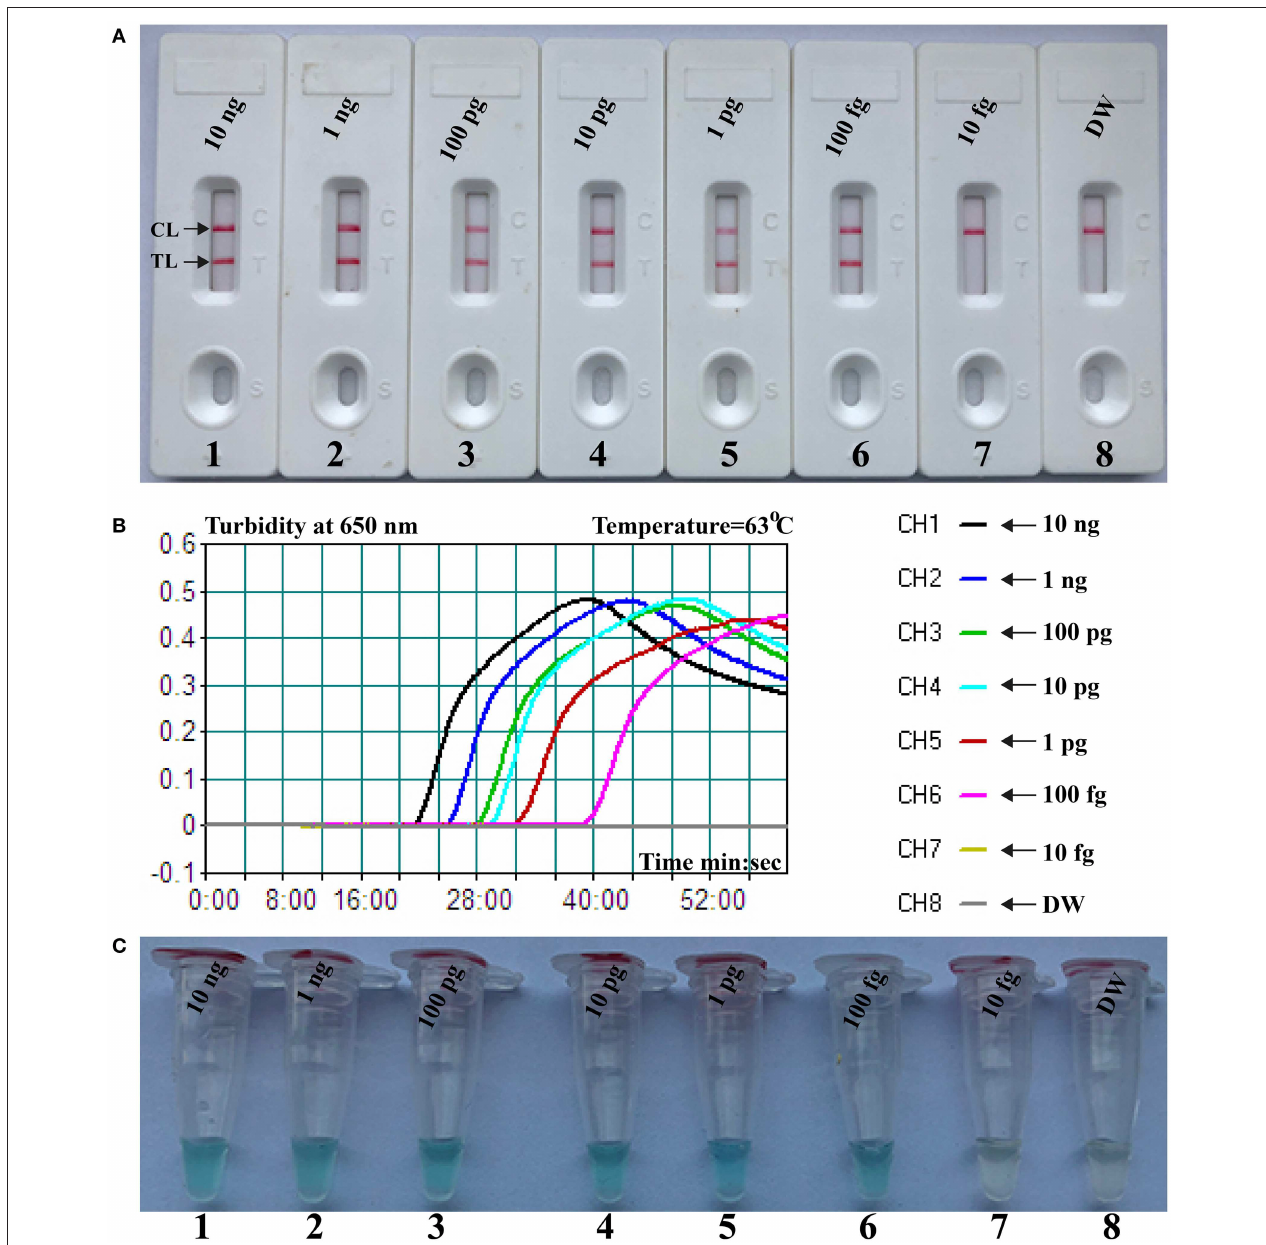
FIGURE 2 | Sensitivity of nanoparticle-based biosensor-supplemented polymerase spiral reaction (NB-PSR) assay using serially diluted Klebsiella pneumoniae [American Type Culture Collection (ATCC) BAA-2146] templates. Biosensor (A) Real-time turbidity (B) and colorimetric indicator (C) were applied for analyzing the PSR products. Biosensor/signal/tube 1, 2, 3, 4, 5, 6, and 7 represent the genomic DNA levels of 10 ng µ l − 1 , 1 ng µ l − 1 , 100 pg µ l − 1 , 10 pg µ l − 1 , 1g µ l − 1 , 100 fg µ l − 1 , and 10 fg µ l − 1 , respectively. Biosensor/signal/tube 8, blank control